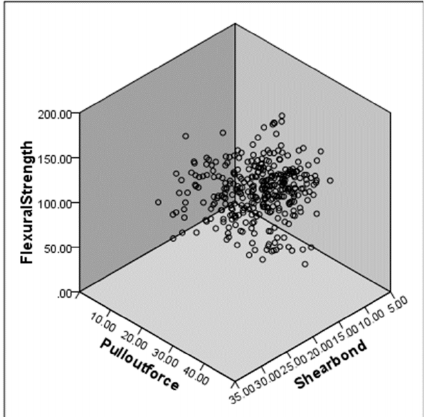
Figure 4. Relationship among flexural strength, pull-out force and root dentin shear bond strength (Flexural strength = 3.264 × Shear bond strength + 1.533 × Pull out bond strength + 10.870, p = 0.002, n =